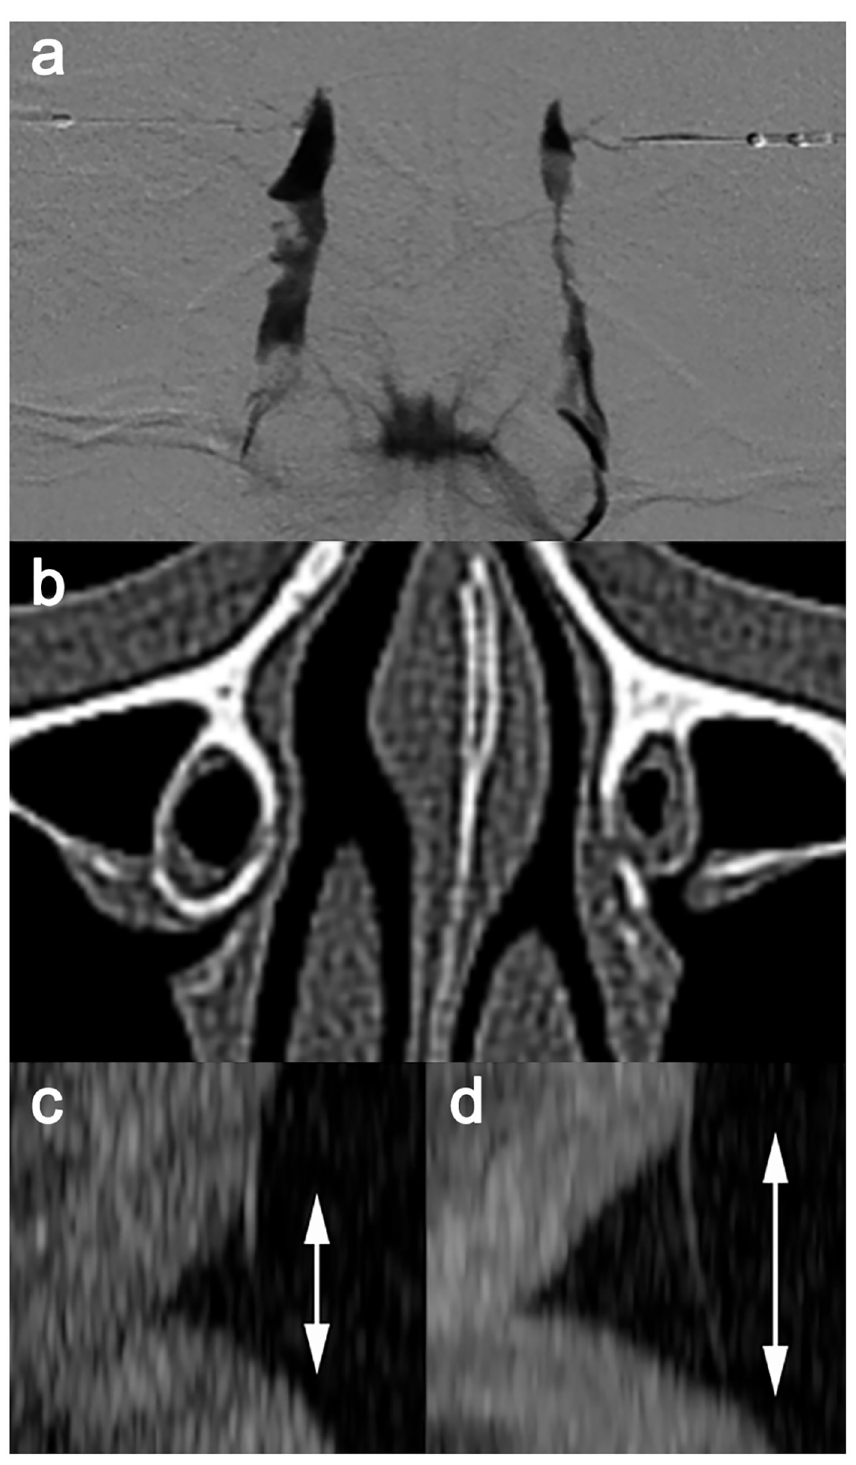
Fig 1. Measuring the bony nasolacrimal duct (NLD) size of a patient showed unilateral success after bilateral nasolacrimal silicone intubation. (a) Preoperative dacryocystography shows a dilated NLD in the right eye and stenosis of the sac-NLD junction in the left eye. (b) A preoperative computed tomography axial image shows that the smallest minor axis diameter of the right eye was larger than that of the left eye (white lines, 5.6 mm vs. 4.2 mm). (c, d) Anterior segment optical coherence tomography shows tear meniscus between the cornea and lower eyelid; tear